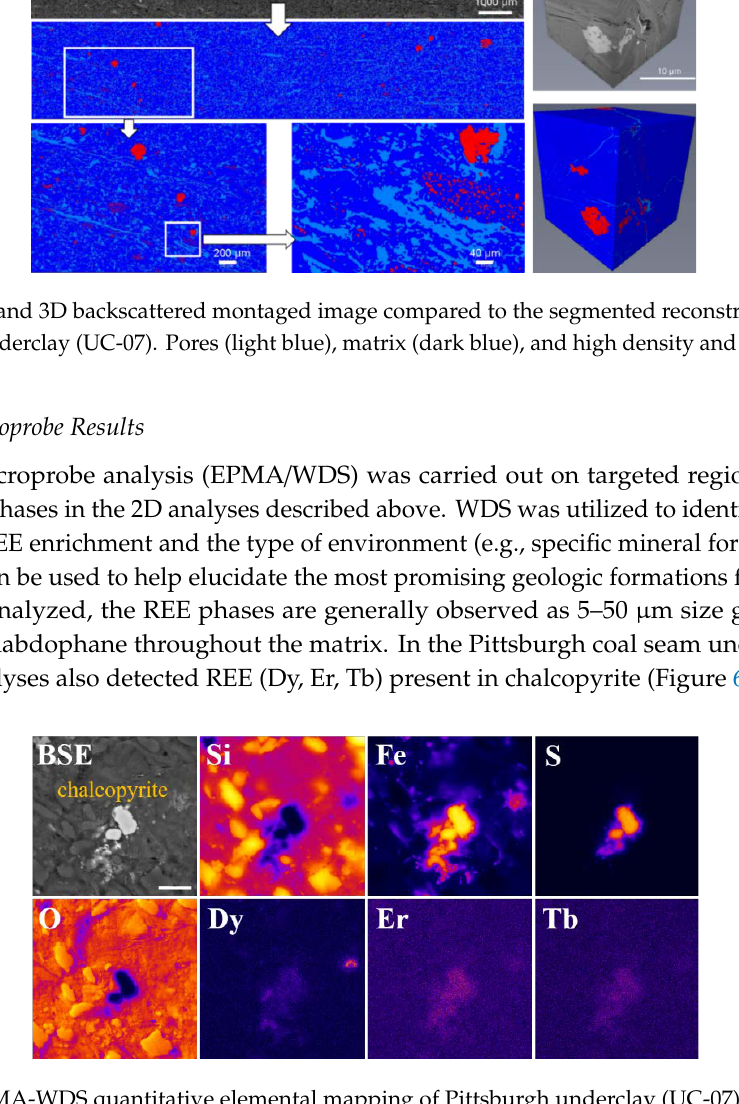
Table 6. Data generated from 3D volumetric reconstruction phase segmentation from individual 2D backscattered image slices. The averaged volumetric % come from multiple sub-volumes.